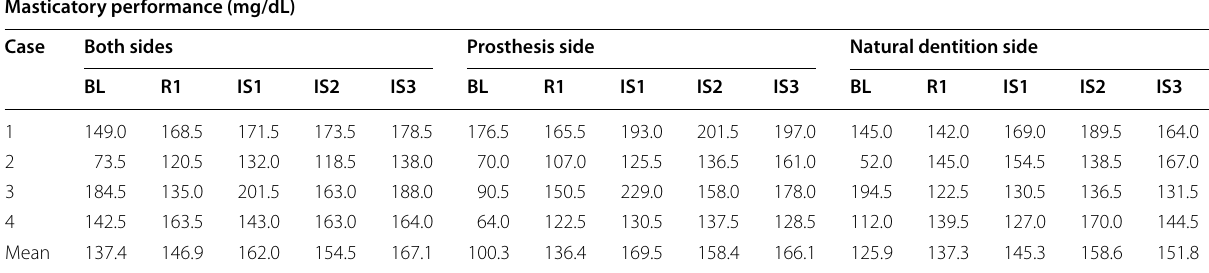
Table 3 Variation in masticatory performance of each patient Masticatory performance (mg/dL)